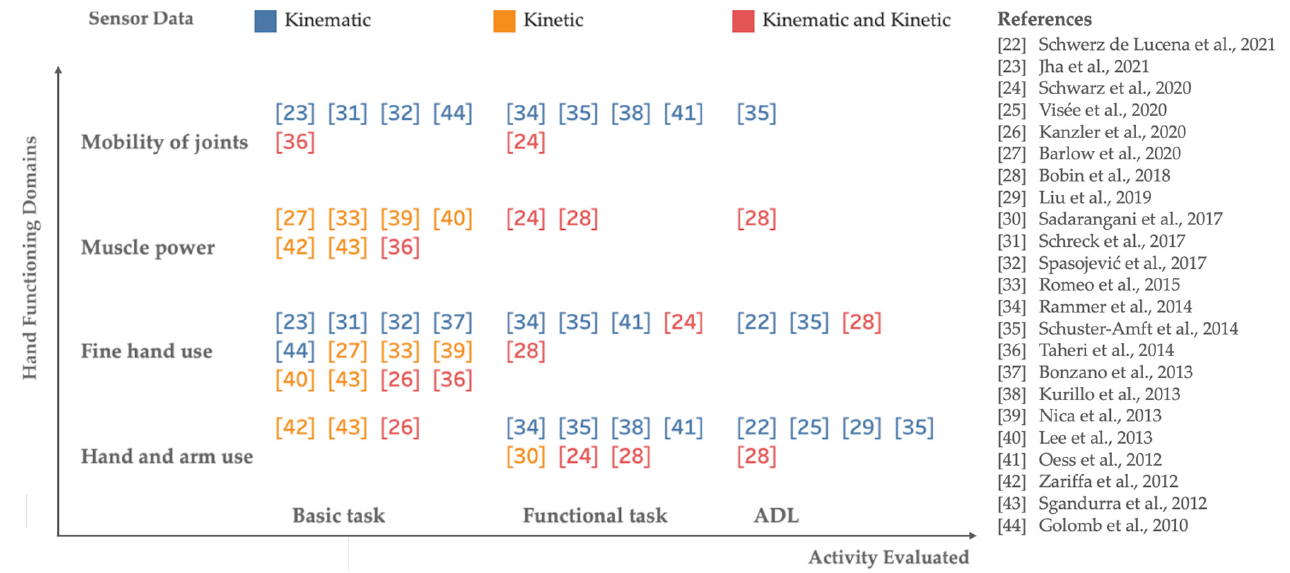
Figure 3. Classification of new systems-aided hand functional assessment based on technology and